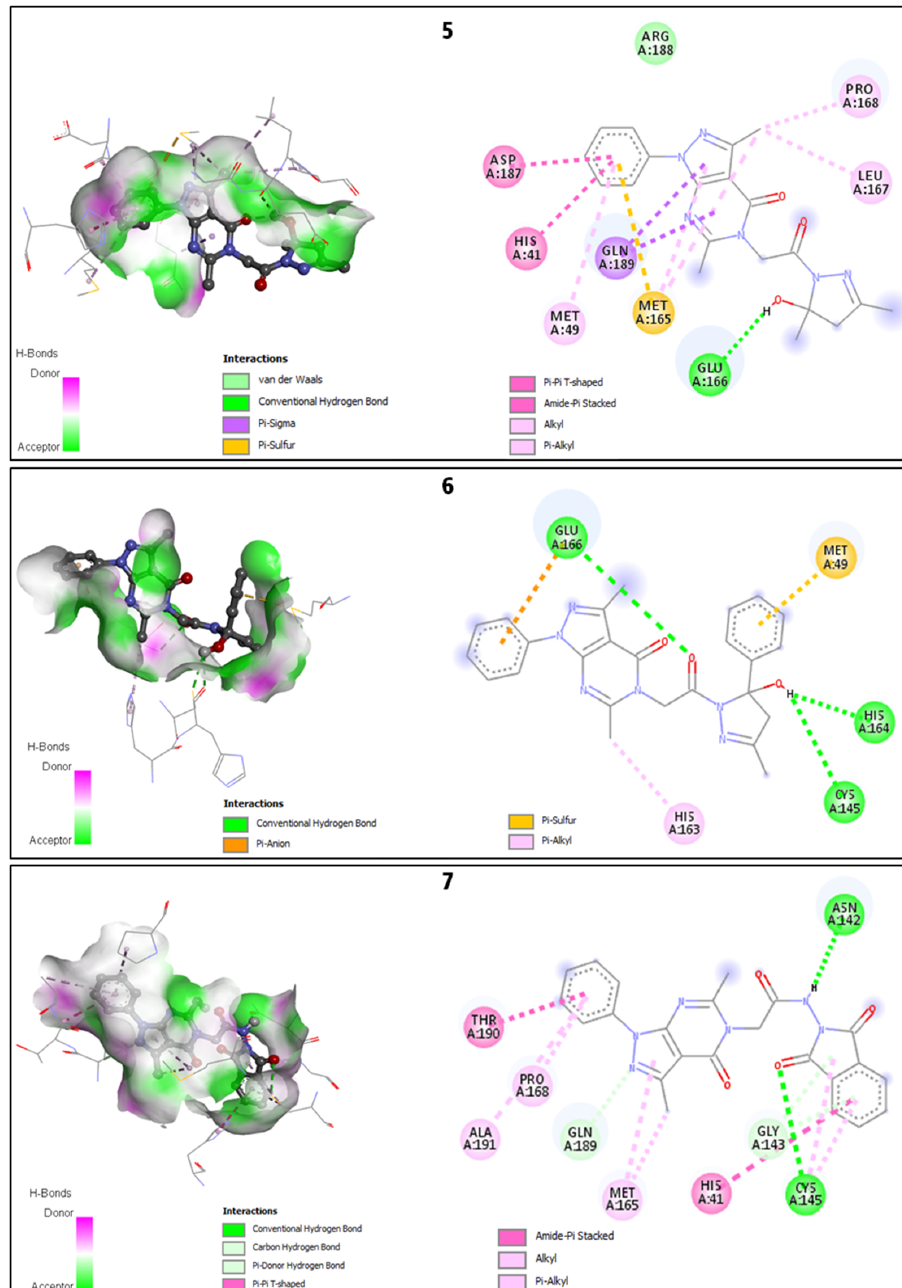
Figure 3. Representation of the 3D structure of the docked compounds 5 , 6, and 7 bound to the pocket region of SARS ‐ CoV ‐ 2 M pro with the hydrogen bond ( left ) and the corresponding 2D diagram of the interactions ( right ).